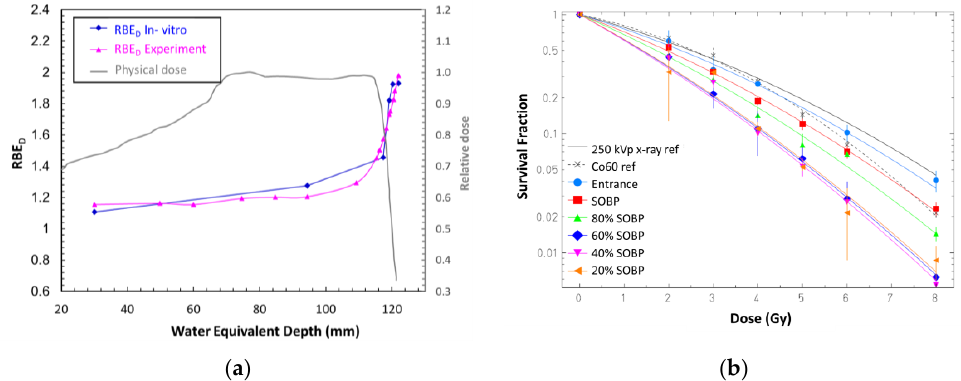
Figure 17. ( a ) Comparison of RBE values obtained from in vitro CHO-K1 cell survival curves and those values obtained using the modified MKM with CHO cell parameters and lineal energy measured with the SOI 3D Mushroom microdosimeter for 2 Gy (RBE D ) delivered at the middle of the SOBP. A 250 kVp X-ray was used as a reference radiation. ( b ) CHO-K1 cell survival curves measured in vitro along the proton SOBP in a PMMA phantom